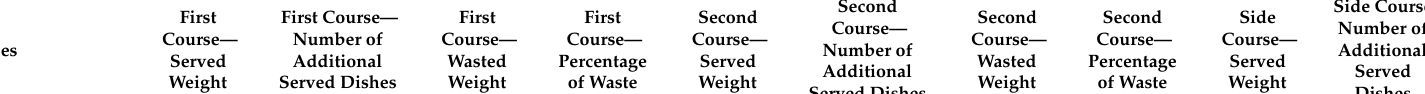
Table 4. Correlation coe ffi cients ( p -values) of the associations between waste weight, percentages of waste and number of additional served dishes for each course.